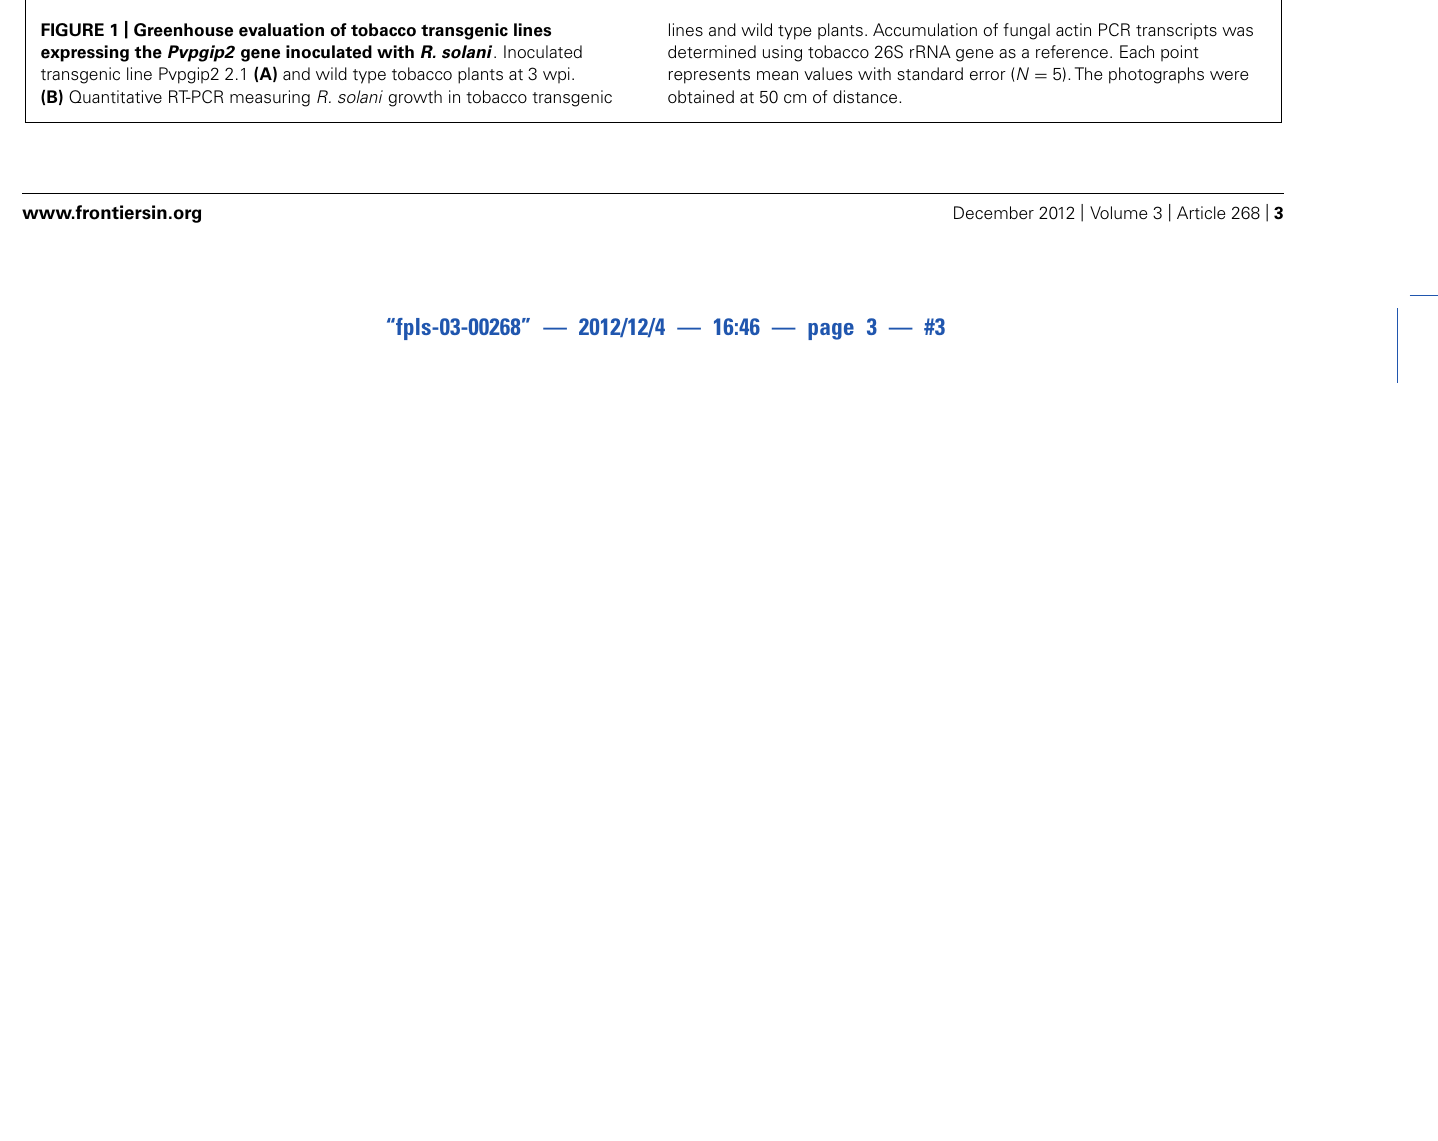
lines and wild type plants. Accumulation of fungal actin PCR transcripts was determined using tobacco 26S rRNA gene as a reference. Each